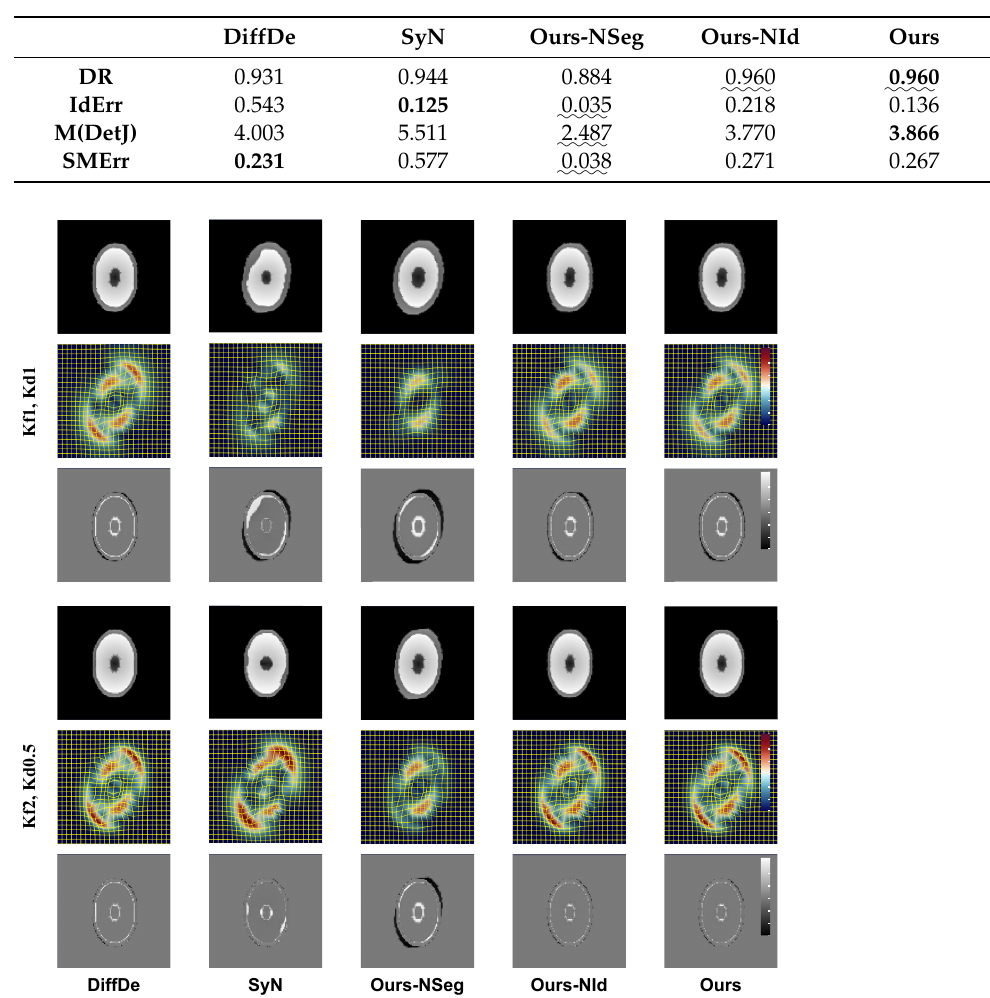
Table 2. The quantitative results of Section 3.2 with smoothing parameters Kf 2 Kd 0.5 are shown. The first row lists the methods, and the second to the fifth rows represent the same evaluation metrics as Table 1. The numbers with wavy lines are the best among Ours-NSeg , Ours-NId , and Ours . The bolded numbers are the best among DiffDe , SyN , and Ours .